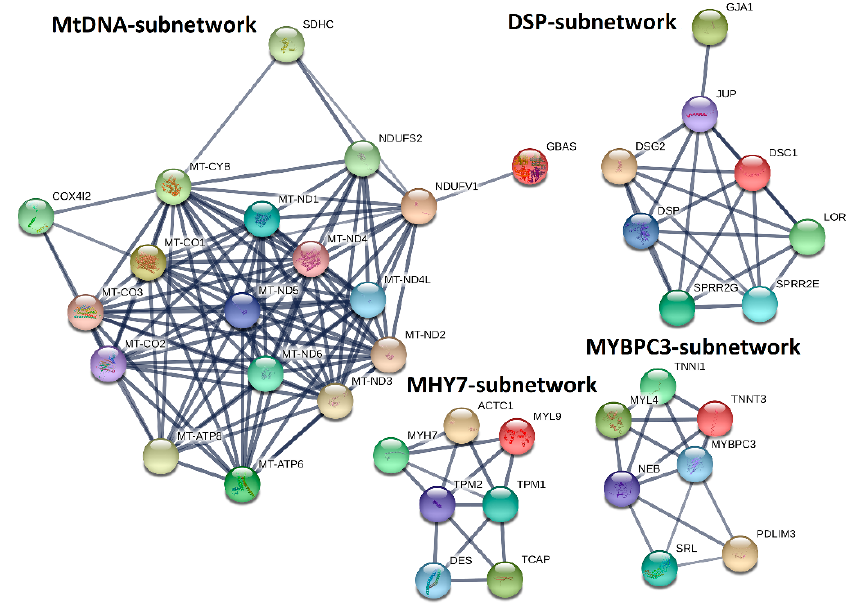
Figure 7. MtDNA-, DSP-, MYH7-, and MYBPC3-subnetworks constructed by integrating co-expression and protein–protein interaction (PPI) network analyses. MHY7- and MYBPC3-involved co-expression modules (M14 and M16) identified by co-expression analysis were used to construct PPI-subnetworks from the STRING database (https://string-db.org/) with the Markov Cluster (MCL) clustering method, for which the inflation parameter was set to 3.